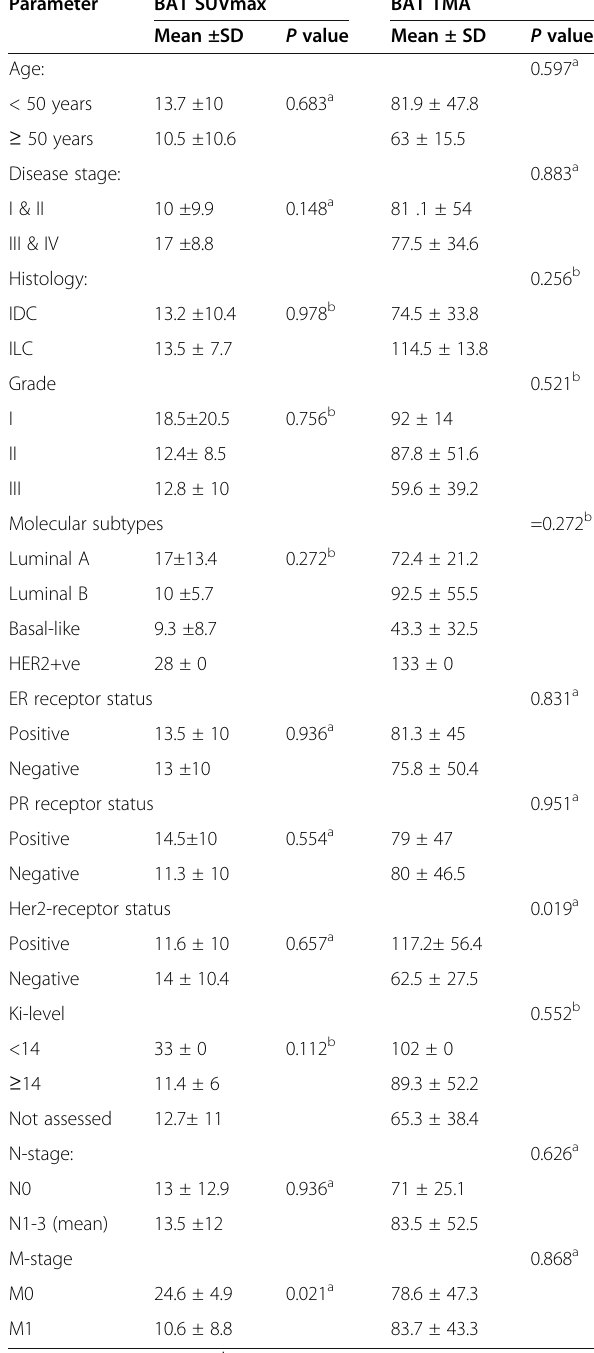
Table 2 Imaging characteristics of activated BAT on 18 F-FDG PET/CT and environmental factors Parameter